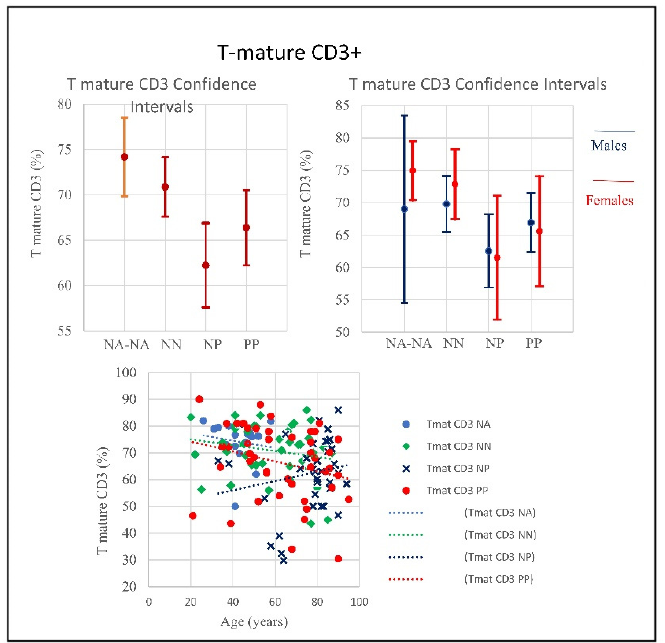
Figure 9. Frequencies of T-mature CD3+ in COVID-19 patients and controls (NP, NN, and NA) (CI 95%). Frequencies include totality and divided by gender. The T-mature quantitative trend decreased in PP and NA, showing no correlation with age, conversely the graphic shows that the NP trend tends to increase, correlated with age. Low T cell count usually indicates conditions affecting the immune system or lymph nodes due to viral infections such as influenza, and aging.